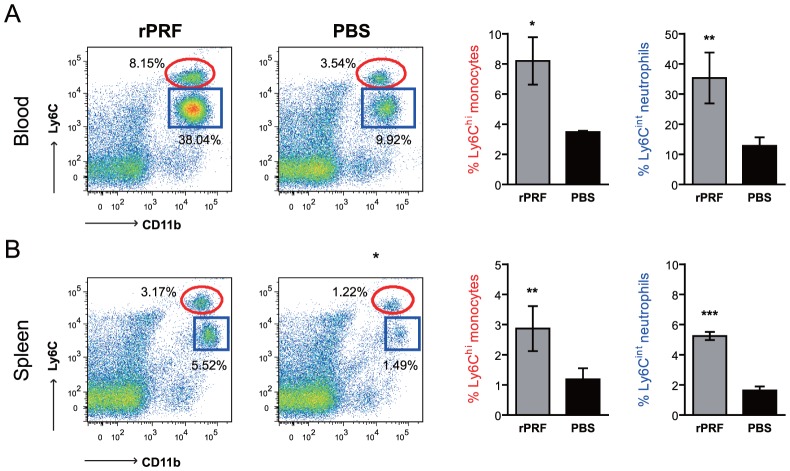
Ly6Chi CCR2+ inflammatory monocytes and Ly6Cint Ly6G+ neutrophils are recruited to the blood and spleen in response to T. gondii profilin.Mice (n = 3–4/group) were stimulated i.v. with 100 ng rPRF (grey) or PBS (black) then blood (A) and spleen (B) cells were collected 4 hours later and analyzed for expression of CD45, CD11b, Ly6C, Ly6G, and CCR2 by flow cytometry. Gating and analysis was conducted on singlet, live, CD45+ cells. CD11b+ Ly6Chi monocytes are within the red elliptical gates and were CCR2+ Ly6G−. Neutrophils are shown in the blue square gates and were CCR2− Ly6G+. The data shown are from one experiment, representative of at least 5 independent experiments. One data point from the PBS group was a statistical outlier, as calculated by Grubb's test, and was excluded from analysis. * indicates p<0.05, ** indicates p<0.01, *** indicates p<0.001.